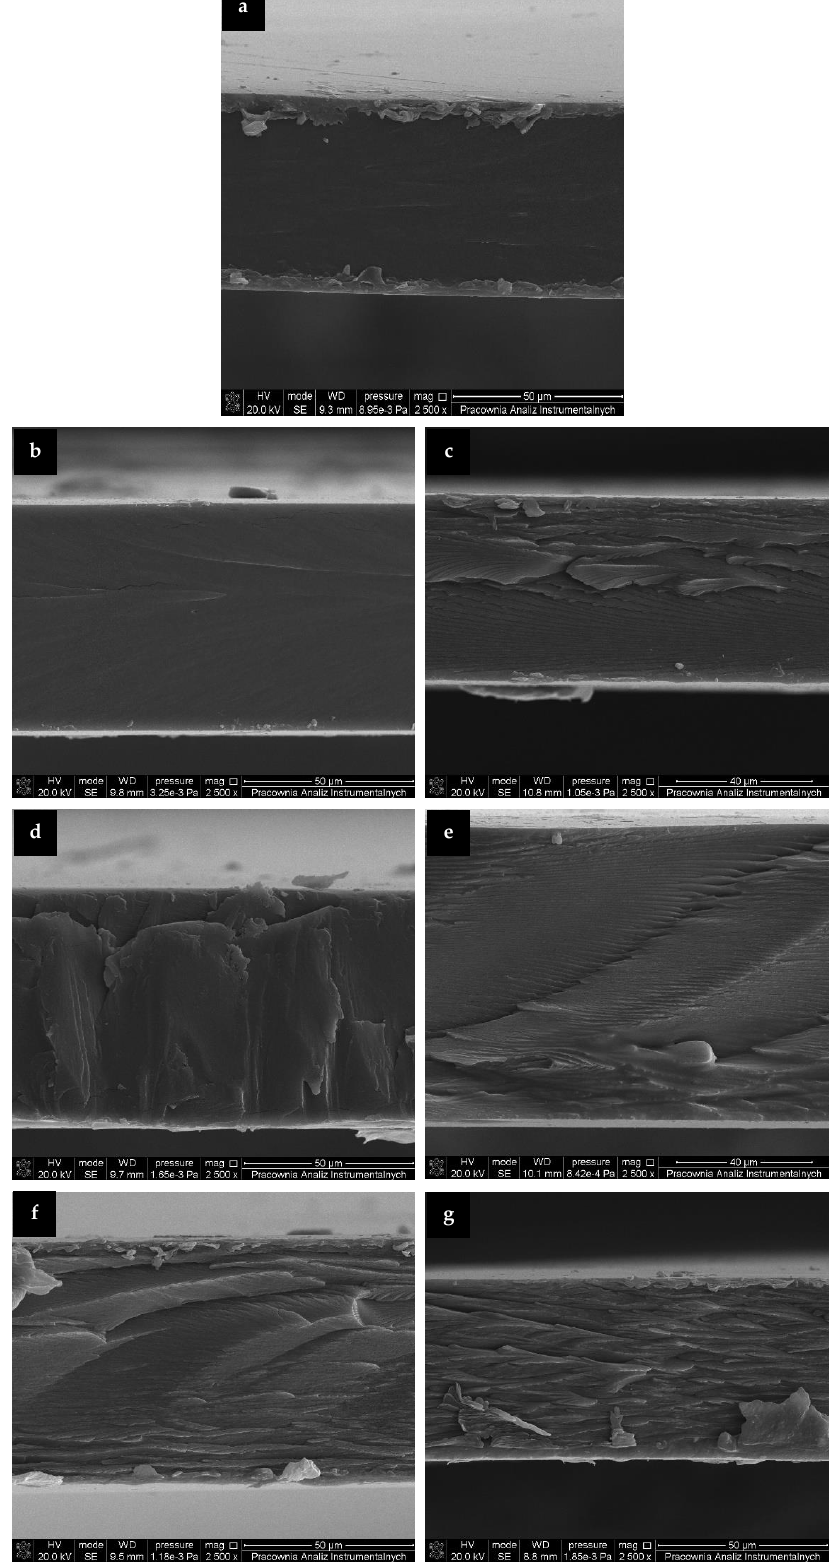
Figure 2. Scanning electron micrographs of cross-sections at 2500× magnification of the prepared gelatin films: ( a ) control film, ( b ) F+RM-WE-4%, ( c ) F+RM-MWE-4%, ( d ) F+RM-WE-8%, ( e ) F+RM- MWE-8%, ( f ) F+RM-WE-12%, and ( g ) F+RM-MWE-12%.